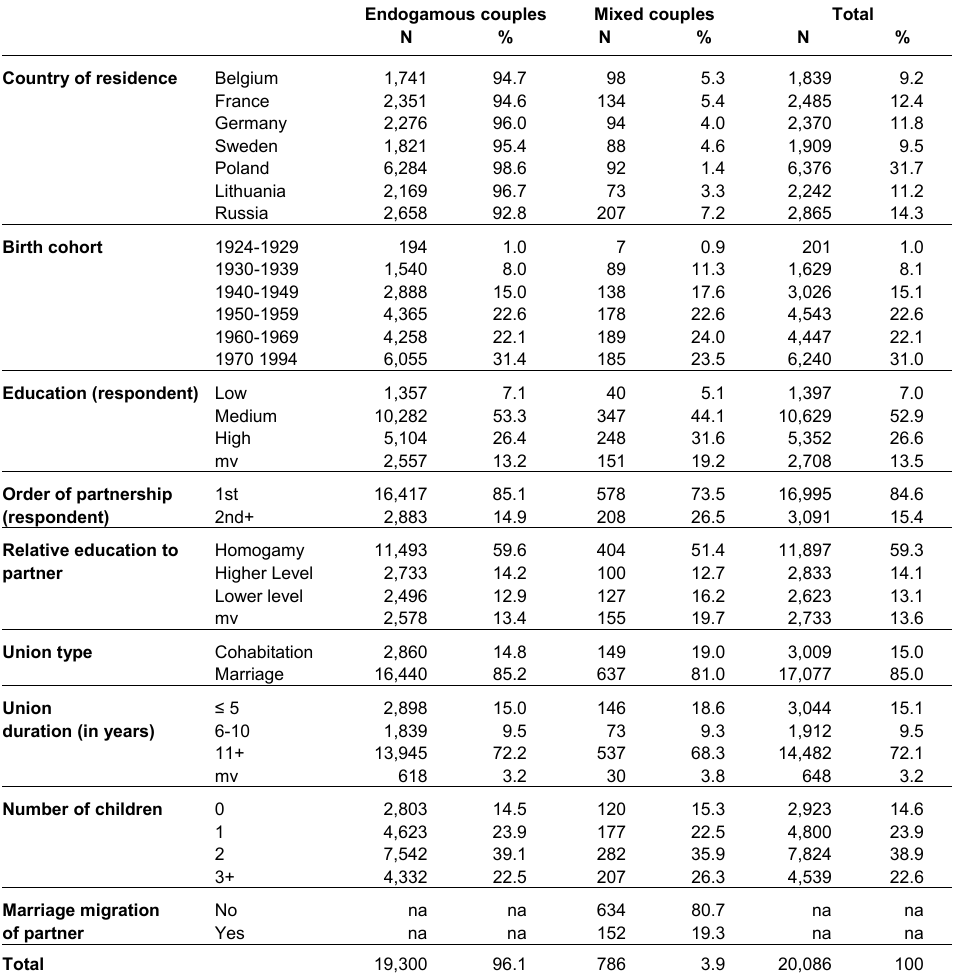
Table 1.1 : Descriptive overview of the sample for native women, by couple type Endogamous couples Mixed couples Total N % N % N